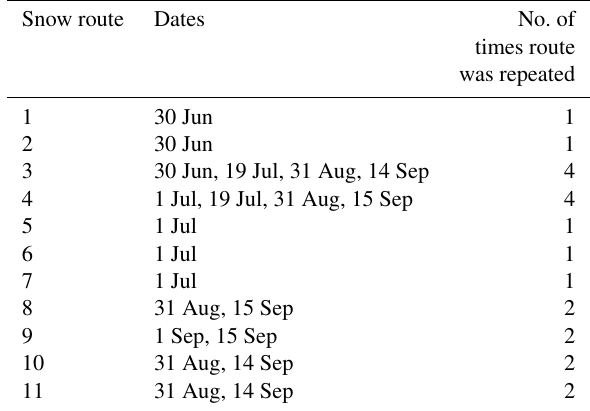
Table 1. Dates and repetition times for each snow route during win- ter 2011. Snow